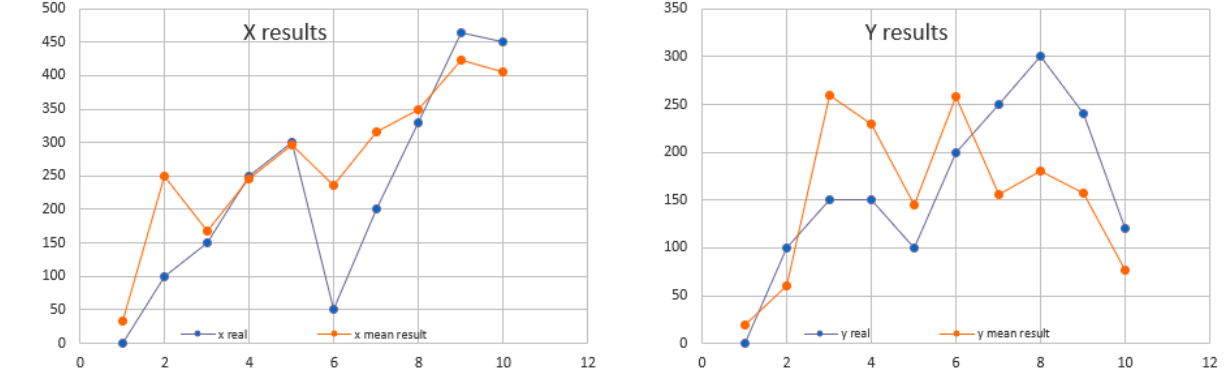
Figure 5. Location results on x and y-axis using trilateration for three Beacons.